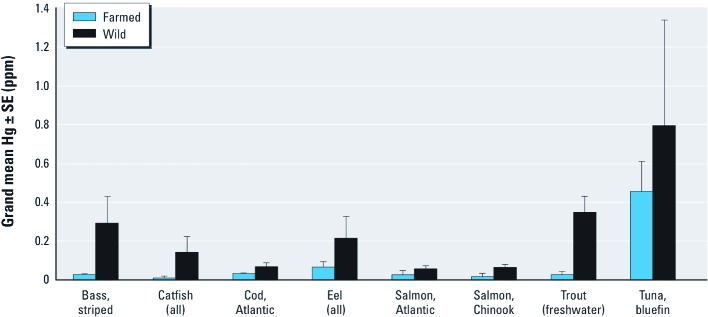
Grand mean Hg ± SE in farmed and wild seafood items by category.